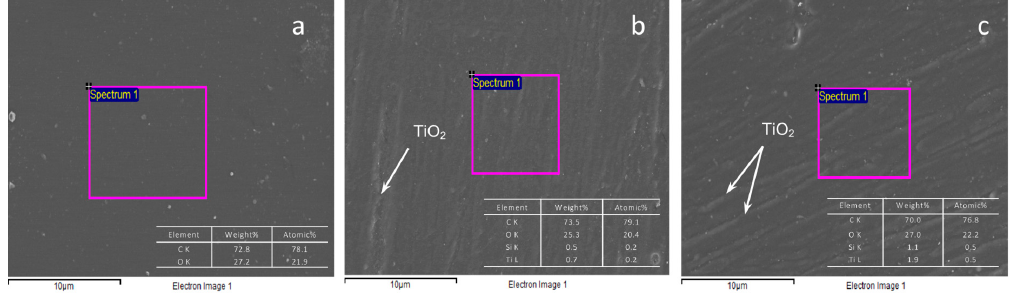
Figure 3. Scanning Electron Micrographs showing surface morphologies of sample ( a ) PG2E2, ( b ) T-PG1E2, and ( c ) T-PG3E2.